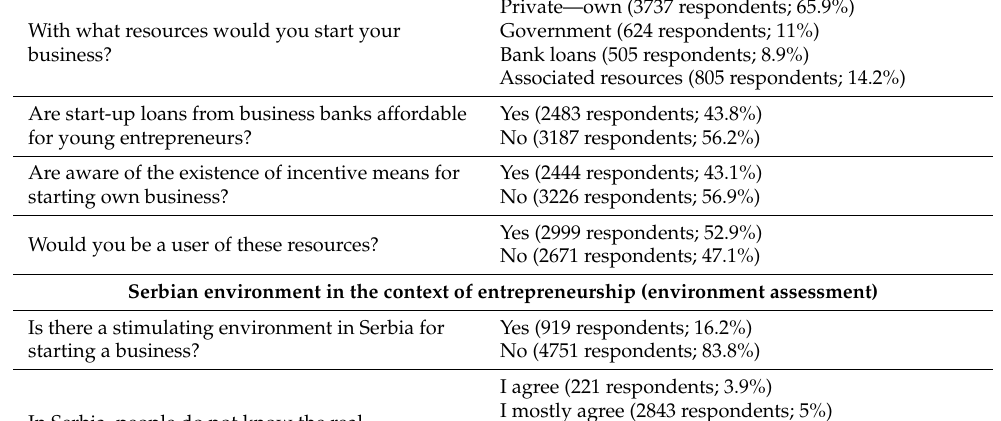
Table A2. Cont. Students’ awareness of existing incentive means (awareness of incentive means) With what resources would you start your